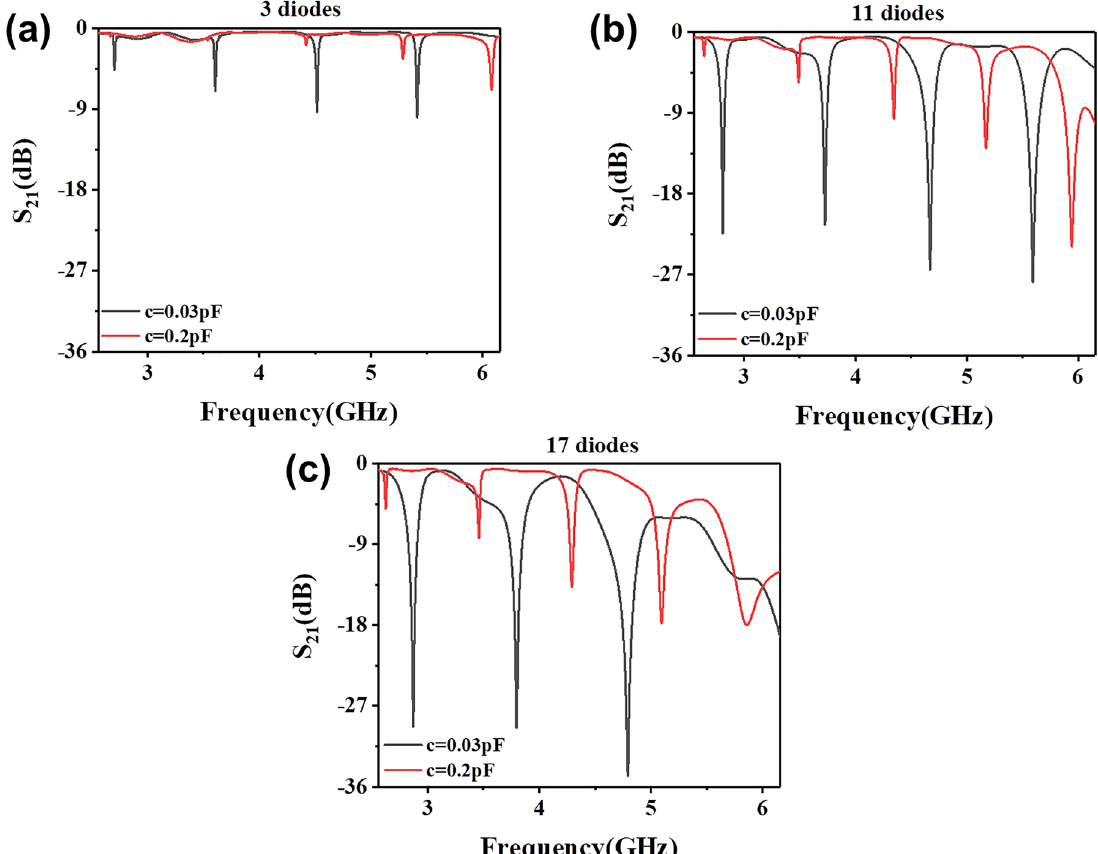
Figure 3: S 21 curves of the SSPP MZI structure with (a) 3, (b) 11 and (c) 17 varactor diodes embedded on the upper